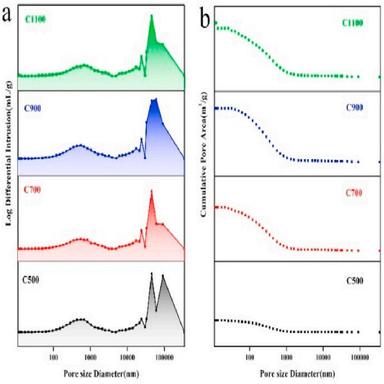
(a) Aperture distribution curves, (b) Accumulated pore area distribution curves.